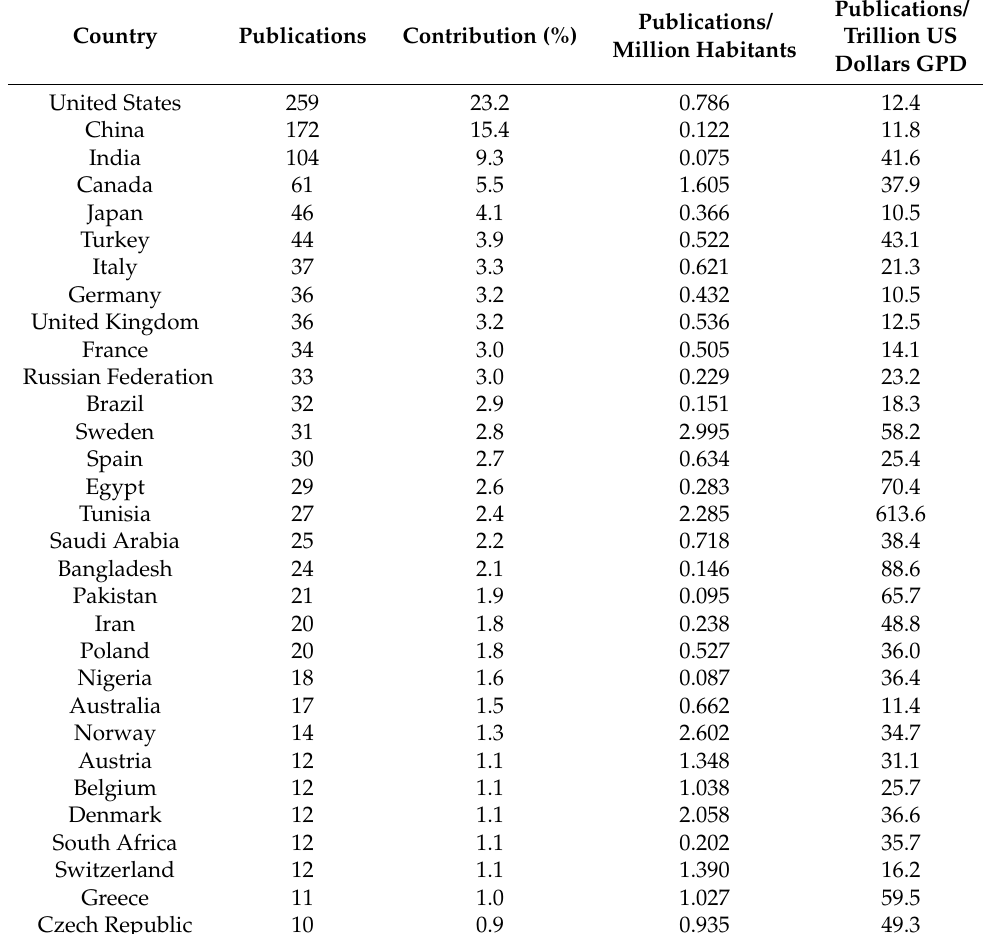
Table 2. The top 31 most productive countries (at least 10 documents).